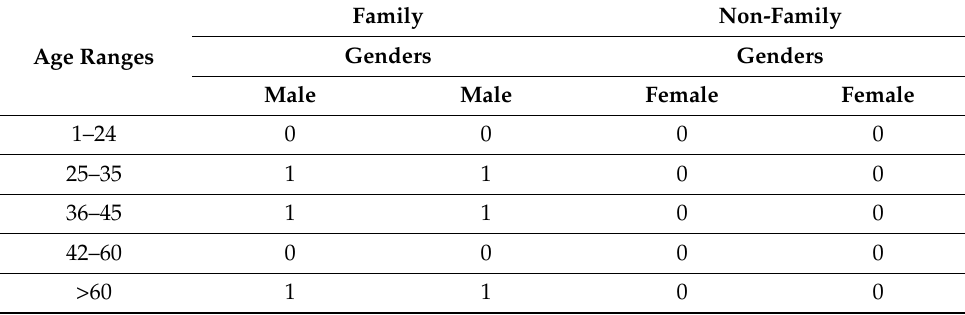
Table 7. Age ranges and